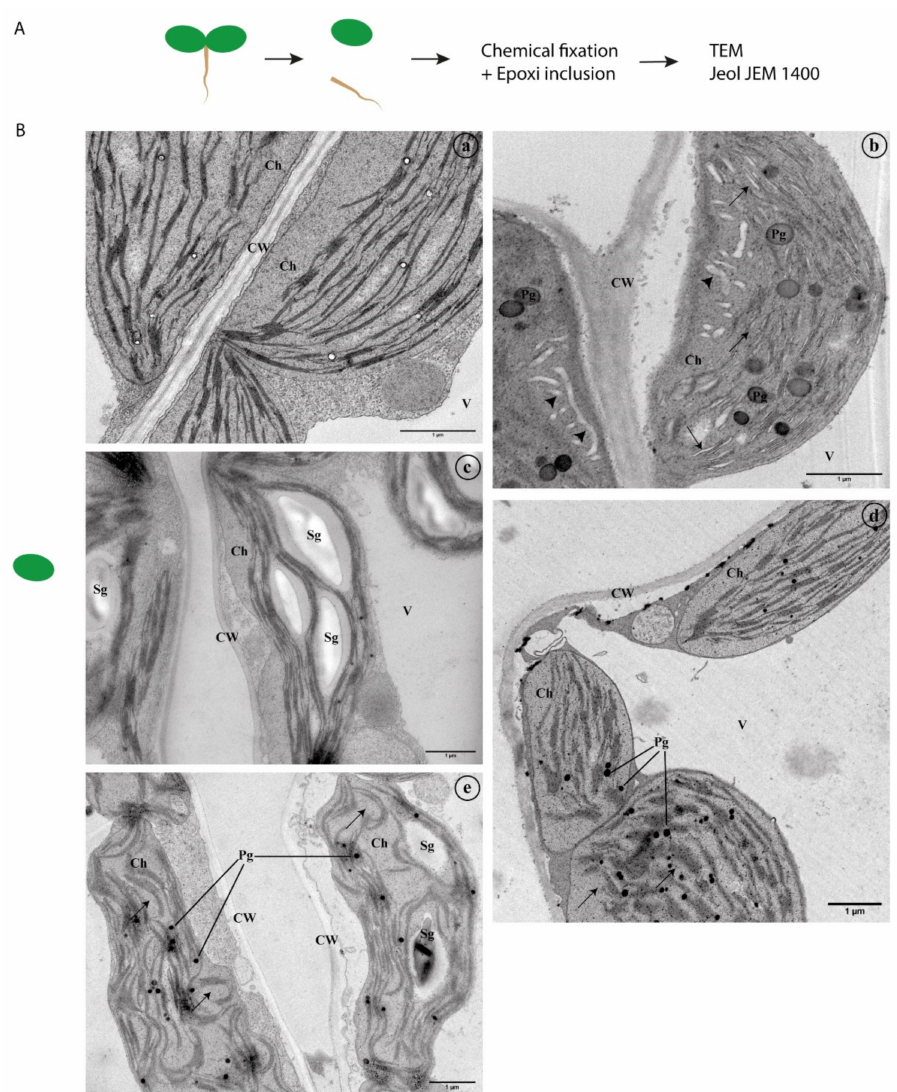
Figure 2. Transmission electron microscopy analysis of A. thaliana leaf cells. ( A ) Workflow to perform transmission electron microscopy. ( B ) A. thaliana leaf cells visualisation under different stress conditions. ( a )—Control; ( b )—Saline Stress (100 mM NaCl); ( c )—Hydric stress (100 mM NaCl); ( d )—Oxidative stress; ( e )—Zinc stress. Abbreviations: CW—Cell wall; Ch—Chloroplast; Pg—Plastoglobuli; Sg—Starch granules; V—Vacuole. Scale bars: 1 µ